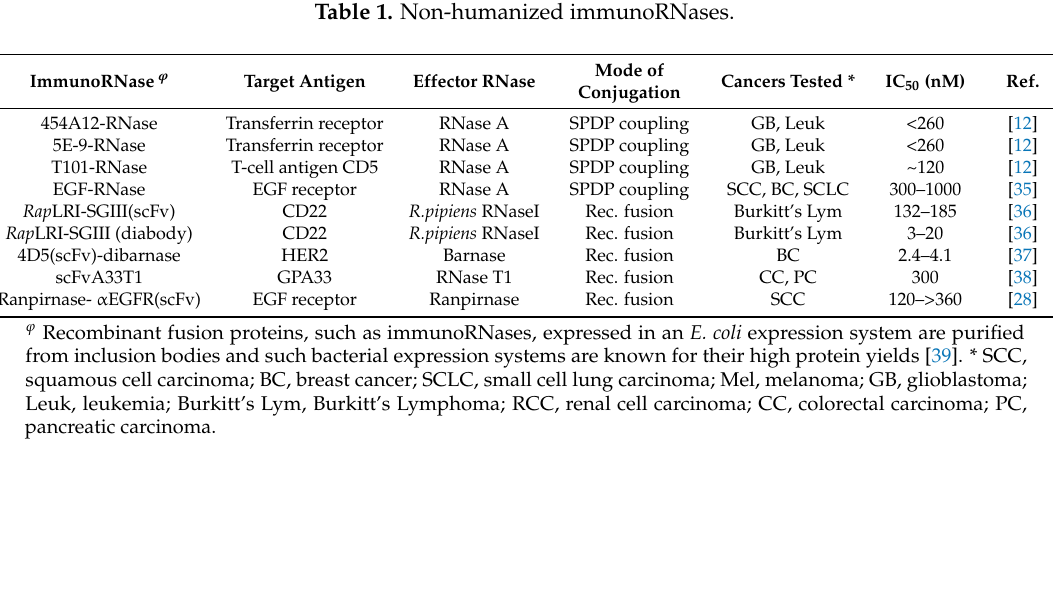
Table 1. Non-humanized